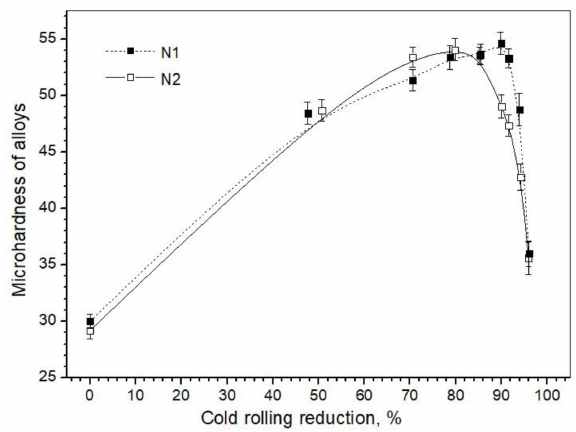
Figure 1. Change in microhardness.